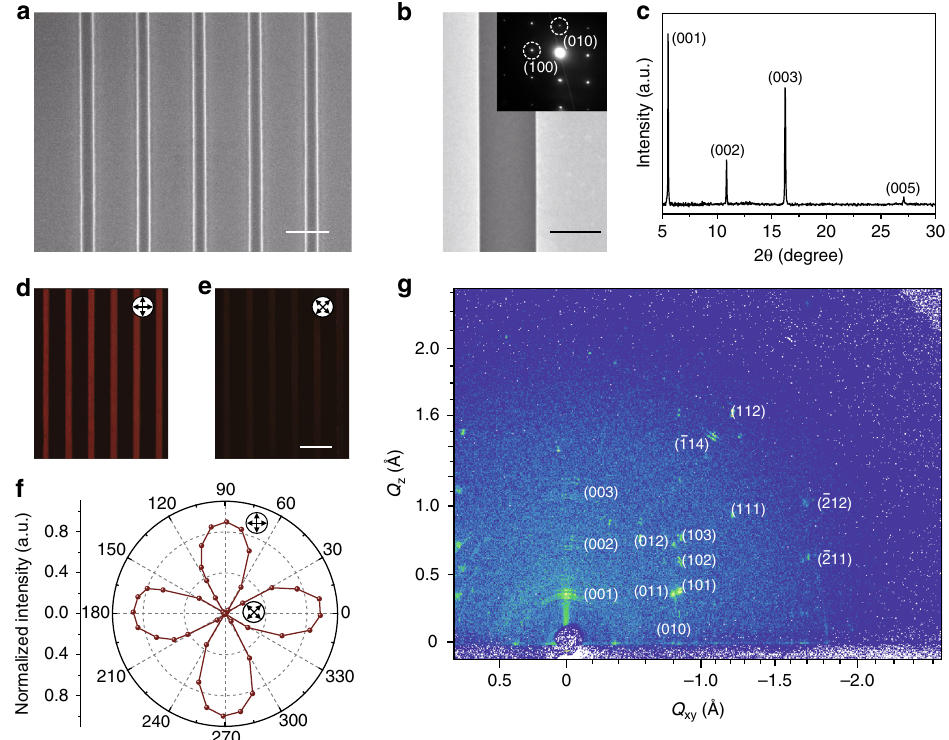
Fig. 2 The morphological and crystallographic characterization of 1D organic arrays. a SEM image of 1D organic single-crystal arrays with precise alignment and regular morphology. b TEM image of an individual organic microbelt with straight boundary and high-quality crystallinity shown in SAED pattern of the inset. c Powder XRD pattern of 1D arrays, conforming to the oriented triclinic TIPS-pentacene with the space group of P 1 and lattice constant of a = 7.6 Å, b = 7.8 Å, c = 16.8 Å, α = 89.2°, β = 78.4°, and γ = 83.6°. d – e Parallel-polarized and cross-polarized re fl ection images of 1D arrays. f Polarizing angle dependent re fl ection intensity of 1D arrays, demonstrating their high-quality crystallinity and uniform crystal orientation. g GIWAXS pattern of 1D arrays, indicating the crystal orientation of 1D arrays along with [010]. Scale bars: a 10 μ m, b 1 μ m, e 20 μ